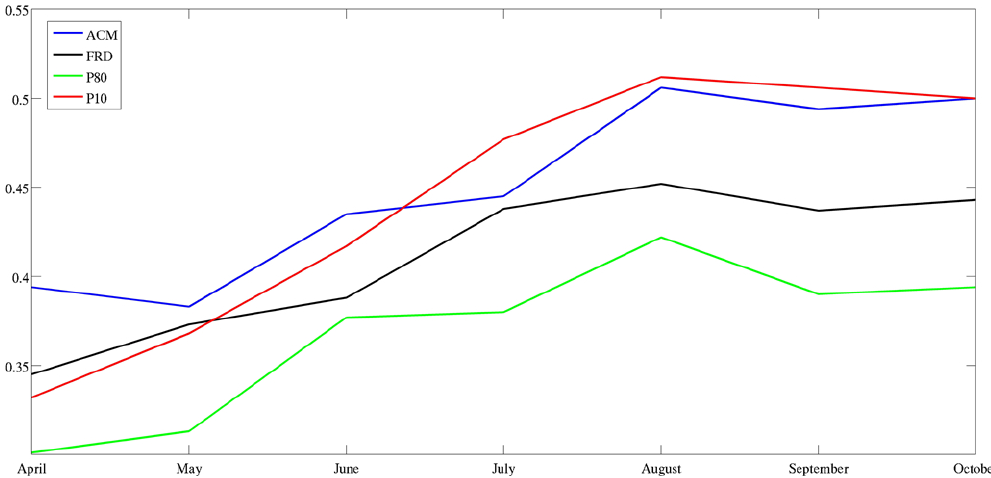
Fig. 2. Spatial skill average ( R ) of each model. To calculate this skill, first, for each station (observed time series), complete times series are estimated using a cross-validation model, with 1-month window length from 1969 to 2008. Then, Pearson correlation coefficients are calculated between the estimated time series and the observed time series. After that, the average of these coefficients is calculated. SSTs from April to July (classic prognosis scheme lead times) and from August to October (perfect prognosis scheme lead times) were analyzed to determine which month has the best skill for the quarter.